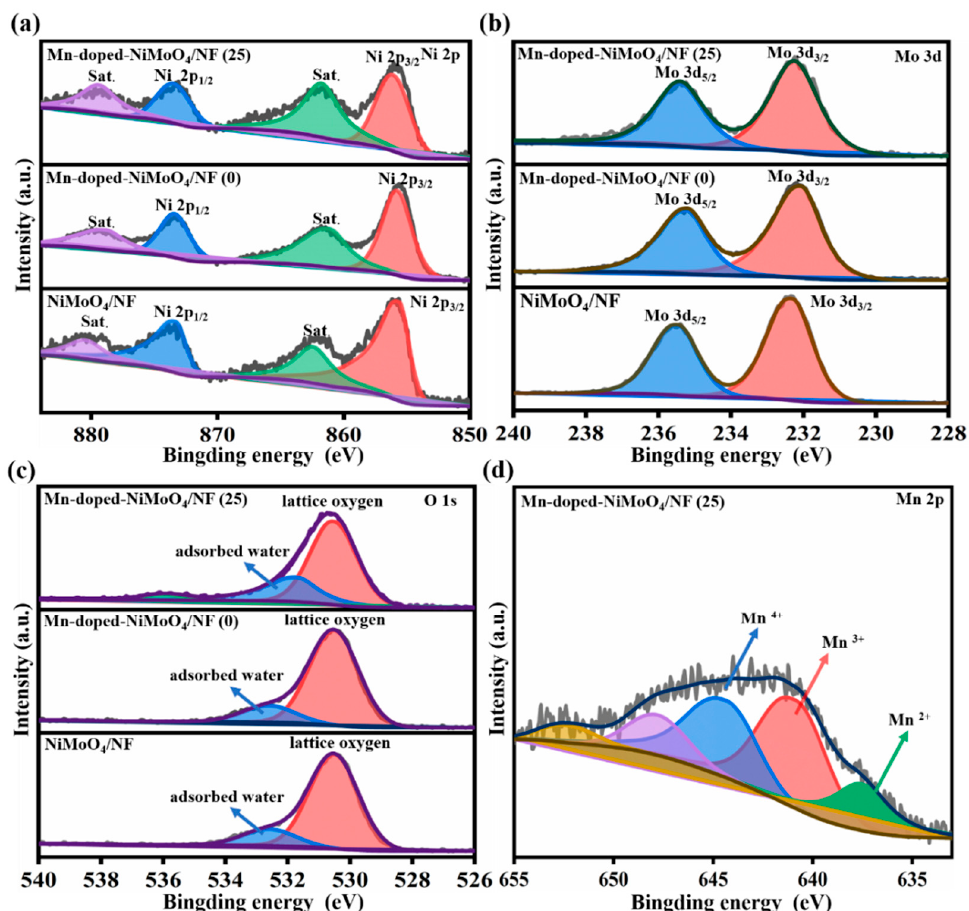
Figure 6. XPS analysis for the Mn-doped-NiMoO 4 /NF (x, x = 0, 25) and NiMoO 4 /NF in ( a ) Ni 2p, ( b ) Mo 3d, ( c ) O 1s, and ( d ) Mn 2p for Mn-doped-NiMoO 4 /NF (25).